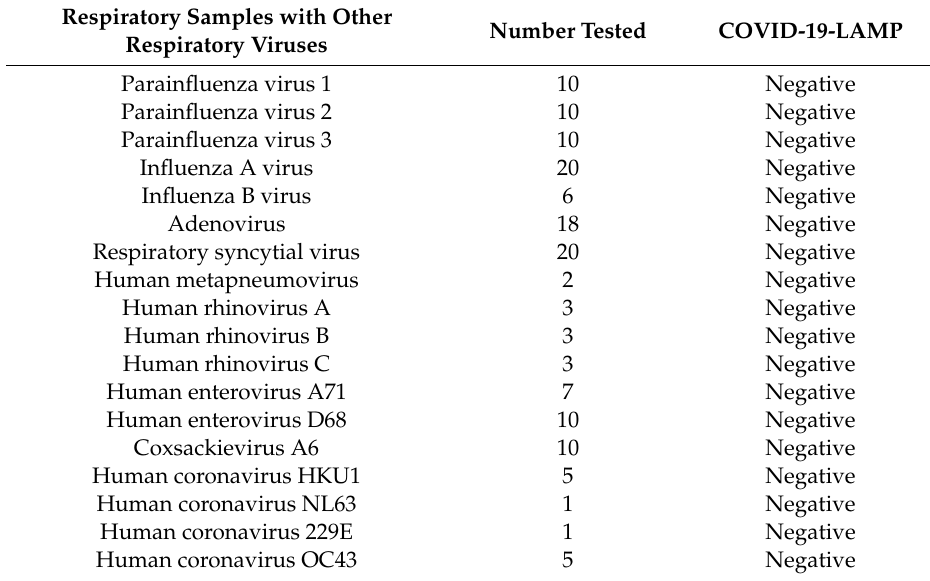
Table 3. Absence of cross-reactivity of COVID-19-LAMP with other human respiratory viruses. Respiratory Samples with Other